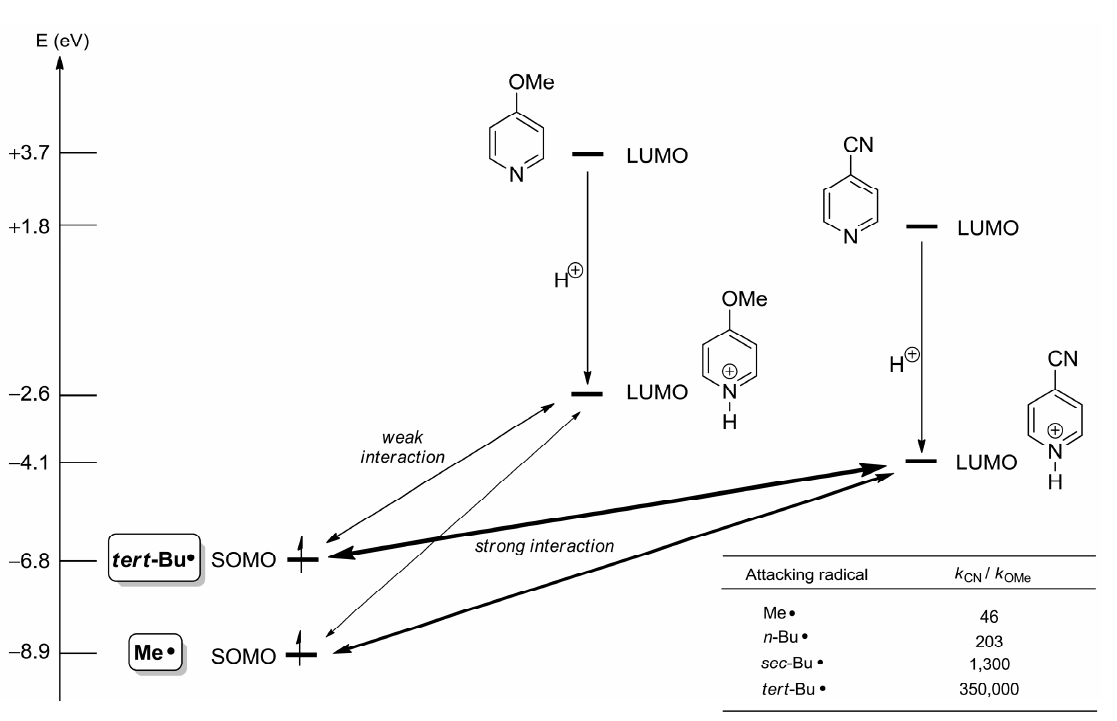
Figure 4. Interactions of frontier orbitals of alkyl radicals with pyridinium cations (values calculated with Gaussian09 D01 at the HF/6-31G* level of theory [4], SOMO energy = − IP)